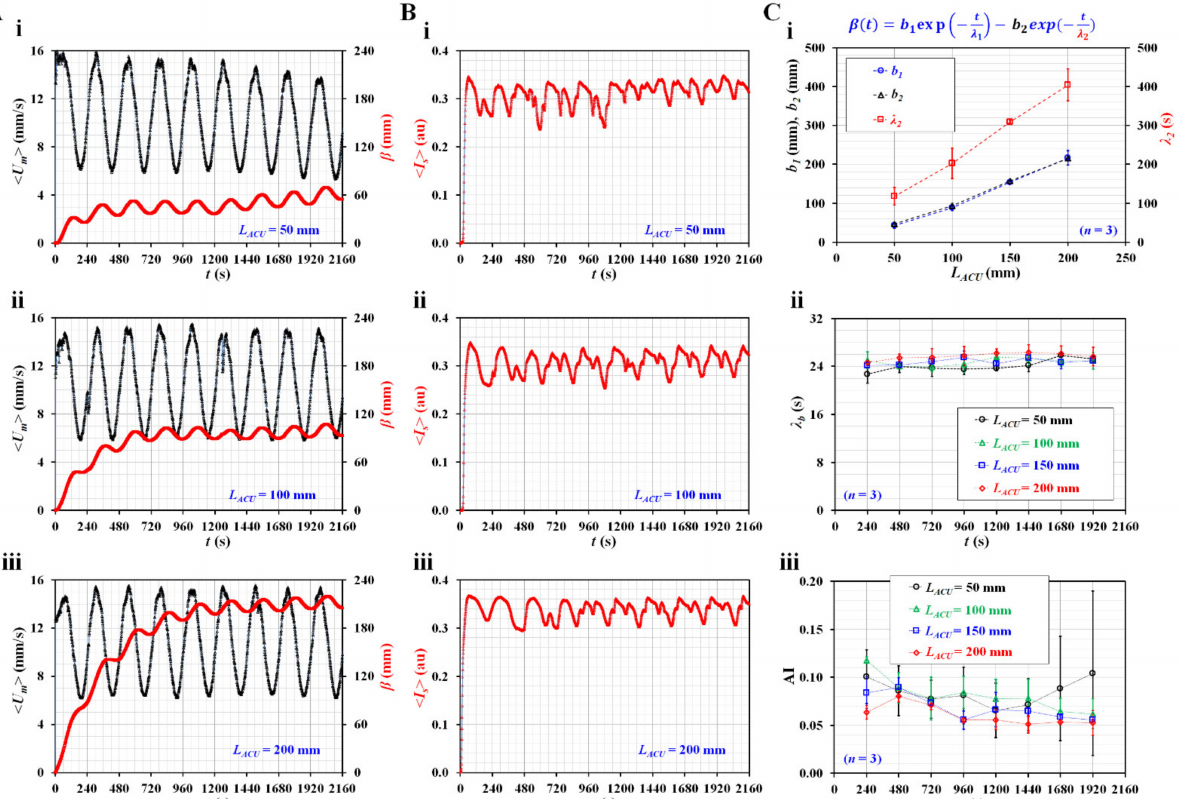
Figure 4. Contributions of air compliance unit (ACU) to three rheological properties in pulsatile blood flow rate. ( A ) Temporal variations of < U m > and β with respect to L ACU = 50, 100, and 200. ( B ) Temporal variations of < I s > with respect to L ACU . ( C ) Quantifications of three parameters (i.e., β , λ b , and AI) with respect to L ACU . ( i ) Variations of b 1 , b 2 , and λ 2 with respect to L ACU . ( ii ) Temporal variations of time constant ( λ b ) with respect to L ACU . ( iii ) Temporal variations of AI with respect to L ACU